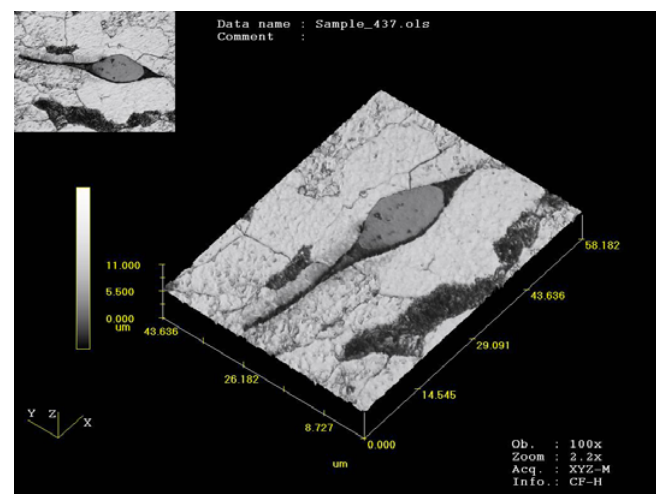
Figure 3: Confocal laser scanning microscope image of a sharp crack-like MnS inclusion in puddled steel.